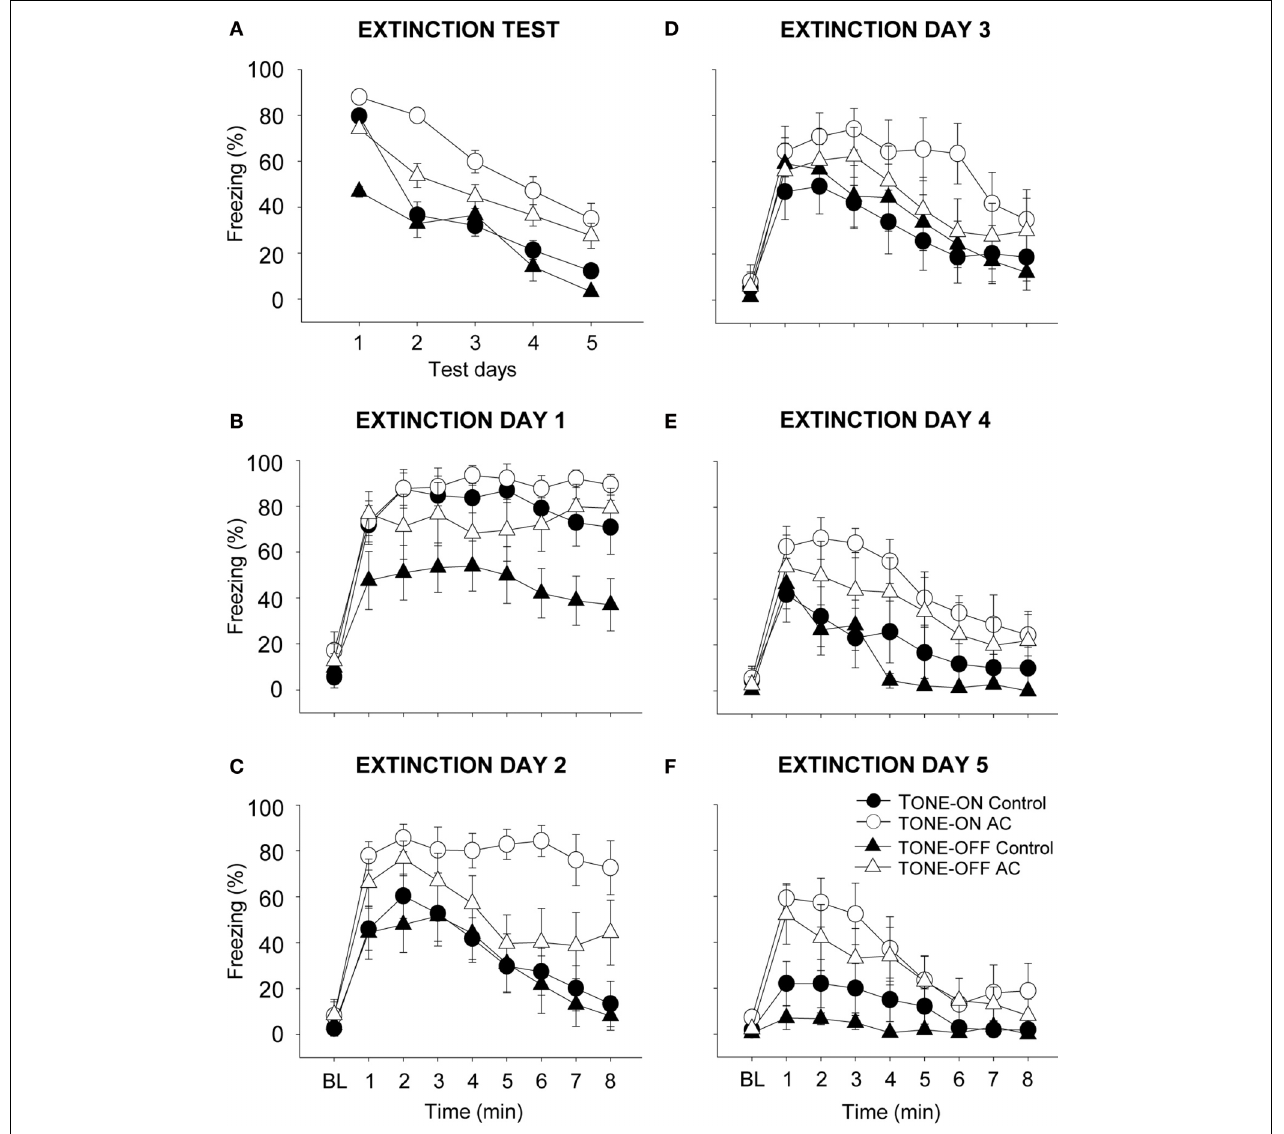
FIGURE 4 | Effects of auditory cortex (AC) lesions on extinction to TONE - ON and TONE - OFF CSs. (A) Mean ± SE (error bars) percentage of freezing during the 8-min CS test in context B across fi ve extinction days. ( B–F ) Mean percentage of freezing during the 3 min baseline (BL) and the 8-min CS test on each extinction days